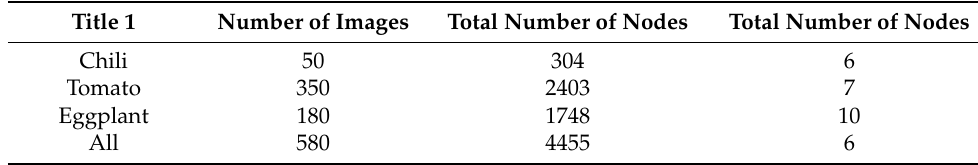
Figure 1. Some examples of datasets. ( a ) Chili; ( b ) tomato; ( c ) eggplant. Table 1. Original dataset information for each crop.